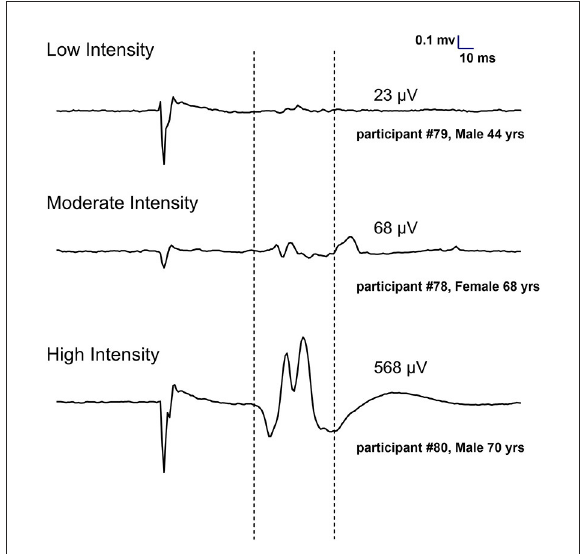
FIGURE2 Individual examples of MEPs recorded at 130% of resting motor threshold in the first dorsal interosseous of the affected hand to assign participants to training groups (Low, Moderate and High intensity). Each trace represents an average of 10 trials.